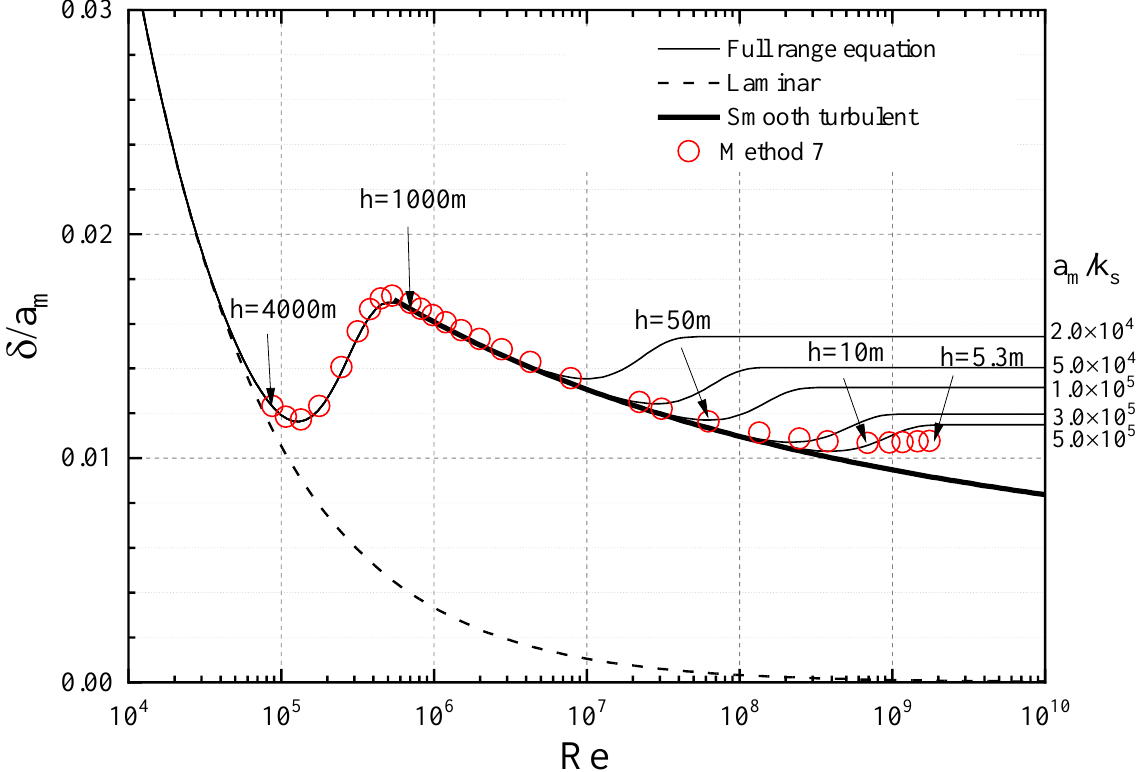
Figure 6. Boundary layer thickness under a shoaling tsunami.